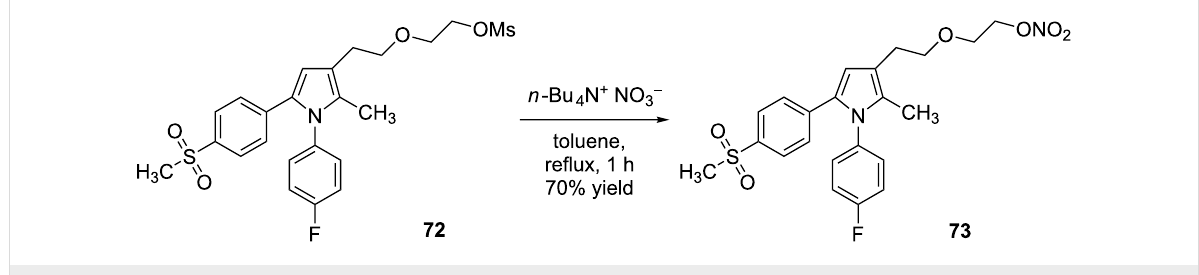
Scheme 12: Synthesis of O -nitrate 73 from O -mesylate 72